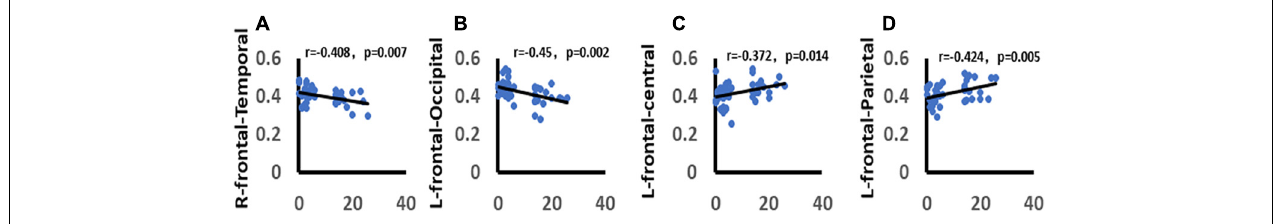
FIGURE 10 | Correlation between depression and functional connectivity. (A) Demonstrates the significant negative correlation between depression and right frontal-temporal lobe function connectivity. (B) Demonstrates the significant negative correlation between depression and left frontal-occipital lobe function connectivity. (C) Demonstrates the significant positive correlation between depression and left frontal-central areas function connectivity. (D) Demonstrates the significant positive correlation between depression and right frontal-parietal lobe function connectivity. Only the significant correlation would show a trend line.